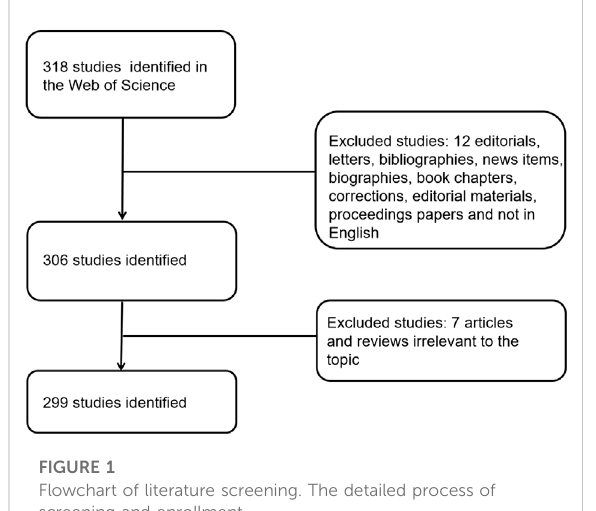
FIGURE 1 Flowchart of literature screening. The detailed process of screening and enrollment.